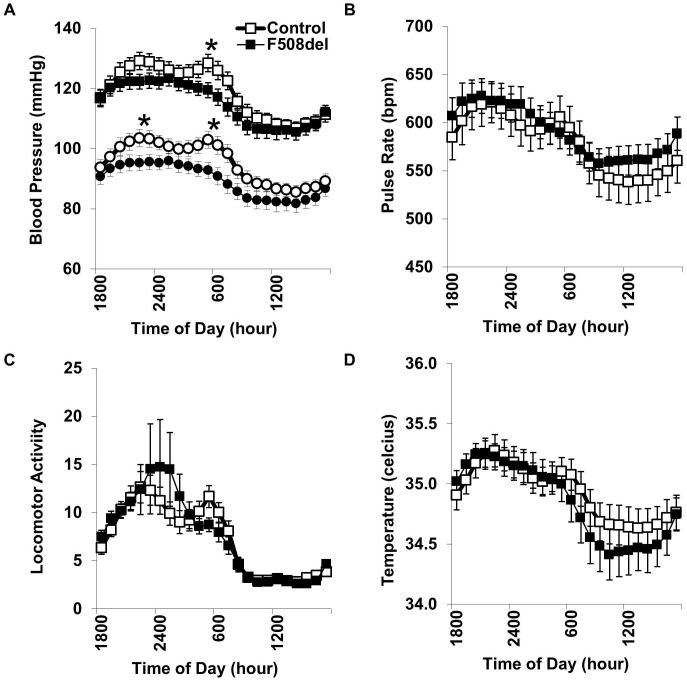
Carotid radiotelemetry.Systolic and diastolic blood pressures (squares and circles, respectively) were measured while mice were housed in their home cage during alternating cycles of darkness (1800 to 0600) and light (0600 to 1800) (A). Compared to wild-type mice (WT, open symbols), heterozygous F508del mice (solid symbols) had lower systolic and diastolic pressures at the dark-to-light transition. Pulse rate (B), locomotor activity (C), and body temperature (D) were not significantly influenced by F508del status. *P<0.05 versus WT; N = 17 WT and 16 F508del mice.